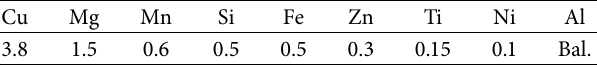
Table 2: Main chemical composition of 2024-T4 aluminum alloy (mass fraction,%).